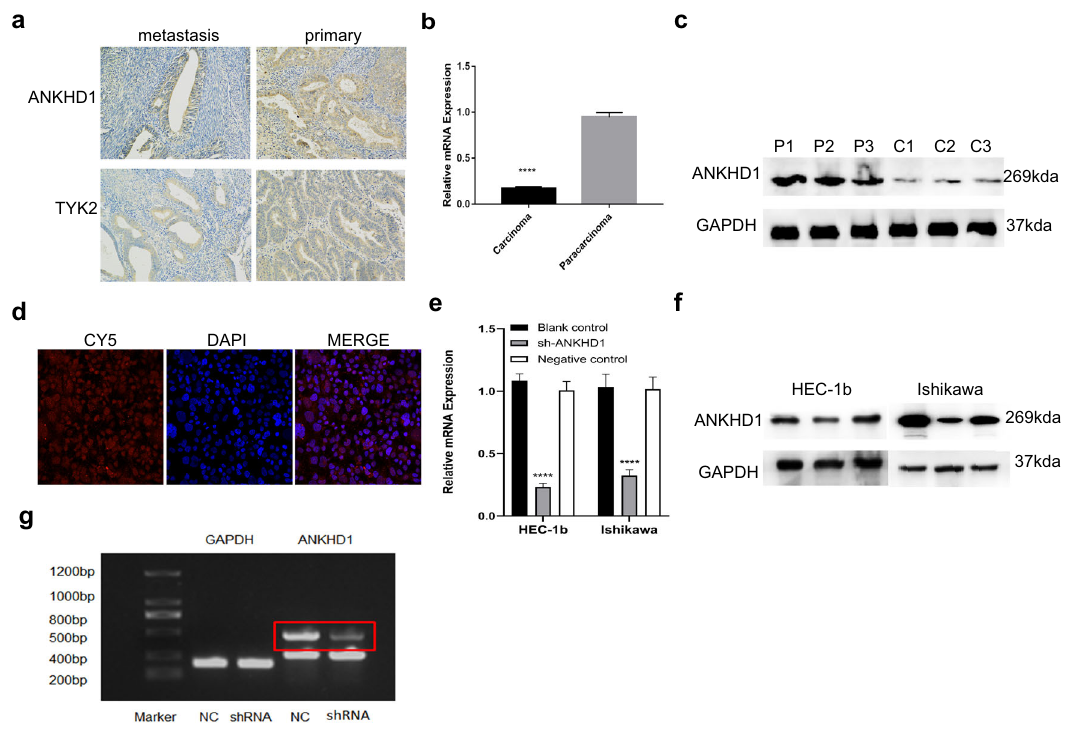
Fig. 5 The expression and location of ANKHD1 in clinical samples and UCEC cells. Immunohistochemistry of ANKHD1 ( a ) between metastasis and primary UCEC samples. RT-PCR ( b ) and Western blot ( c ) for the expression of ANKHD1 in carcinoma and para-carcinoma. Immuno fl uorescence staining of ANKHD1 ( d ). RT-PCR ( e ) and Western blot ( f ) of blank, shRNA, and NC group. The result of DNA electrophoresis ( g ). **** p < 0.0001. Data shown are the mean ± SD of at least three independent